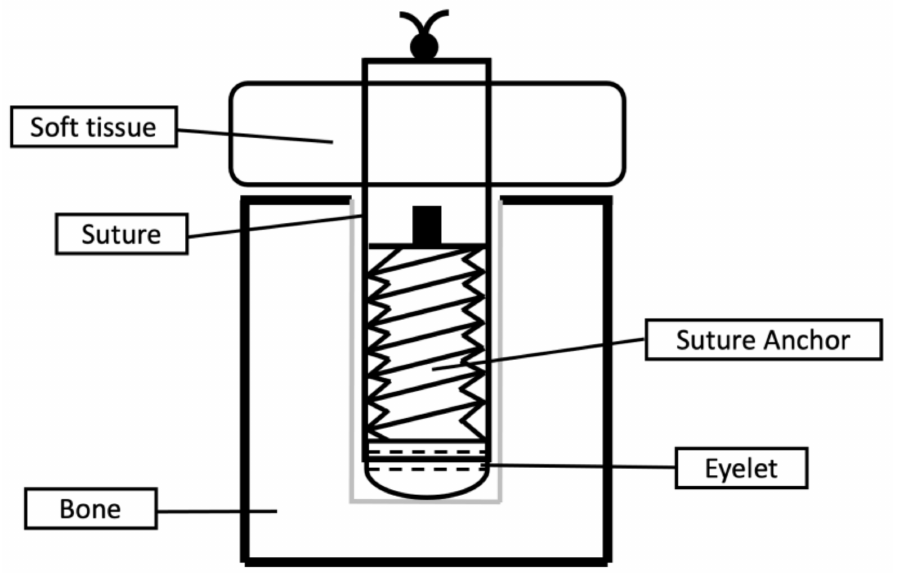
Figure 1. Illustration of the use of a suture anchor for soft tissue repair. The suture anchor is screwed into a predrilled hole in the bone to stabilize the suture. The suture can then penetrate through the soft tissue and be tied in order to fix the soft tissue to the